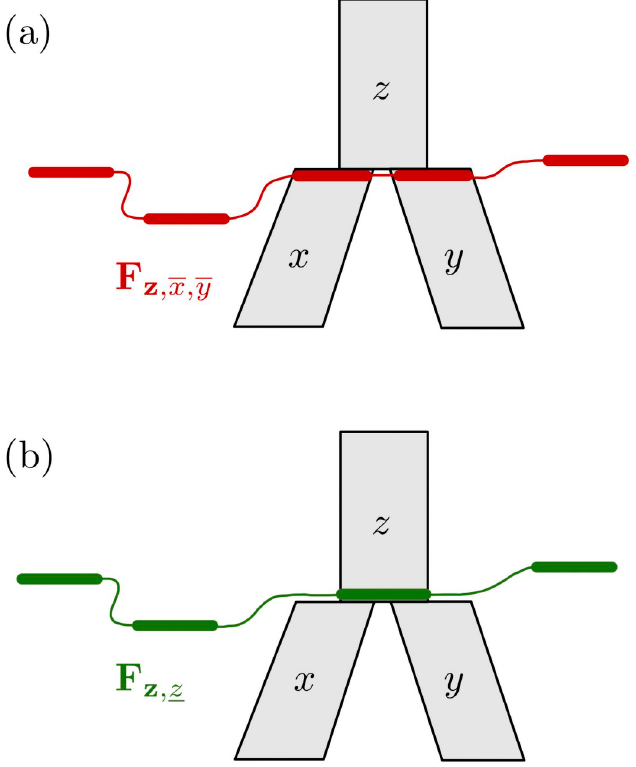
Fig 5. Illustration of Rule 4. Given (a) the partial likelihoods for the z ; x ; y (red) vector of population interfaces, Rule 4 allows us to compute the partial likelihoods for the (green) vector z ; z (b).